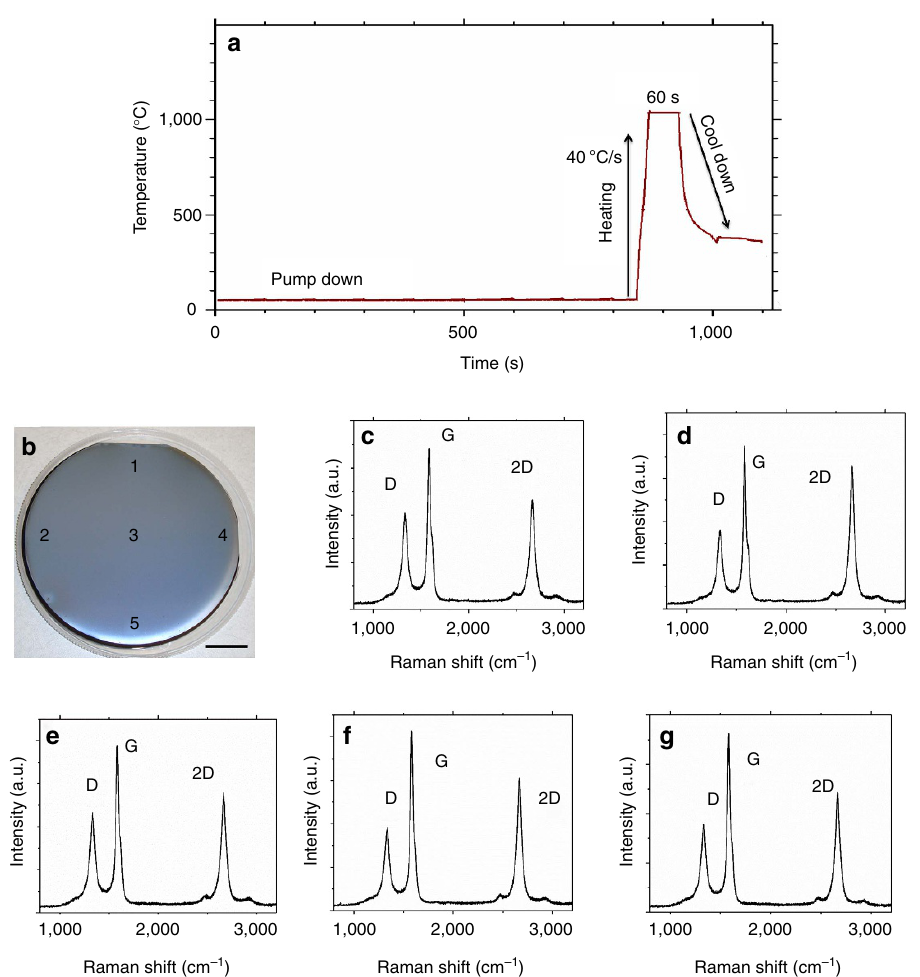
Figure 1 | Wafer-scale growth of graphene on diamond. ( a ) Recipe for the thermal annealing process shows rapid heating of the sample’s temperature up to 1,000 (cid:2) C, keeping the system at high temperature for 60s followed by rapid cooling down to room temperature. ( b ) A photograph of the 4-inch diameter wafer covered with graphene after the annealing process is shown and the Raman analysis of the sample at five random spots is presented. ( c ) Corresponds to spot 1, ( d ) to spot 2, ( e ) to spot 3, ( f ) to spot 4 and ( g ) to spot 5. Scale bar, 2cm ( b ).